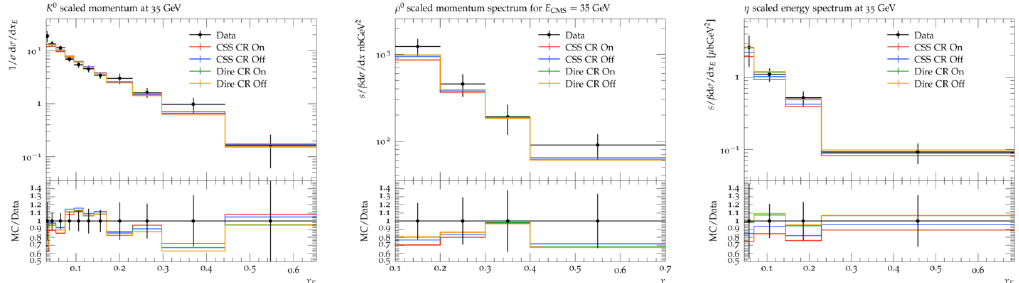
Figure 16: Scaled momentum of K 0 mesons (left) by C ELLO [ 74 ] , and of ρ 0 (centre) and η (right), both by J ADE [ 75,76 ] .